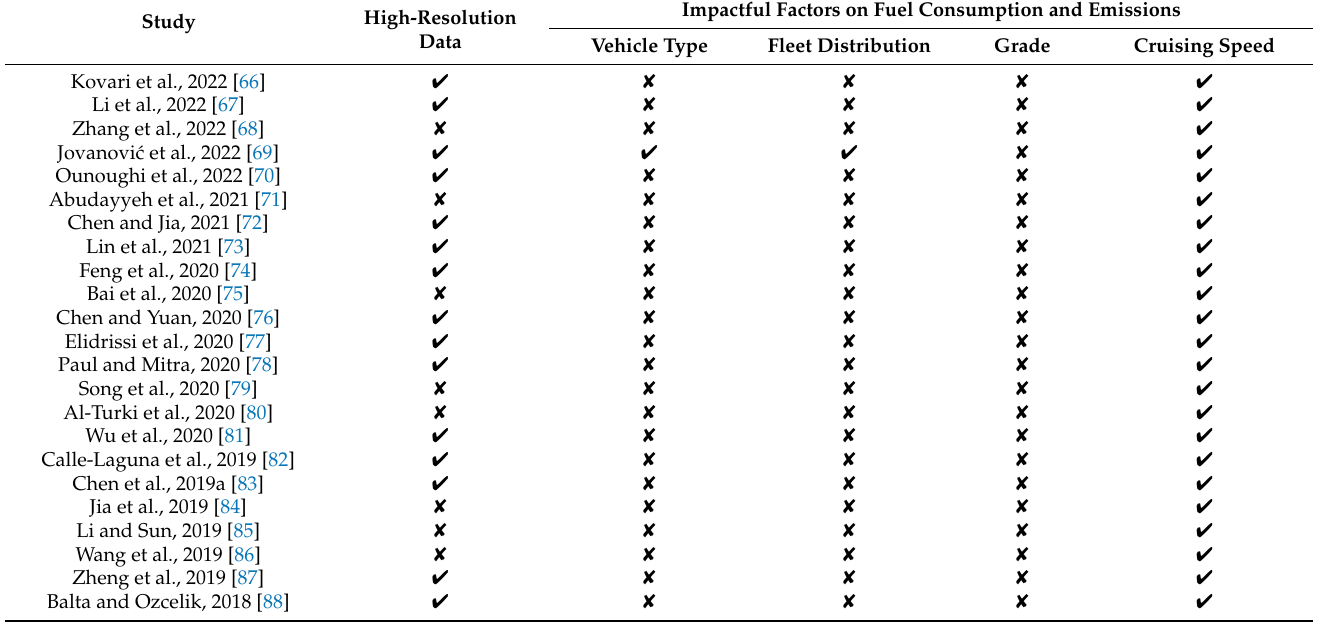
Table 1. Data fidelity and factors used in the reviewed